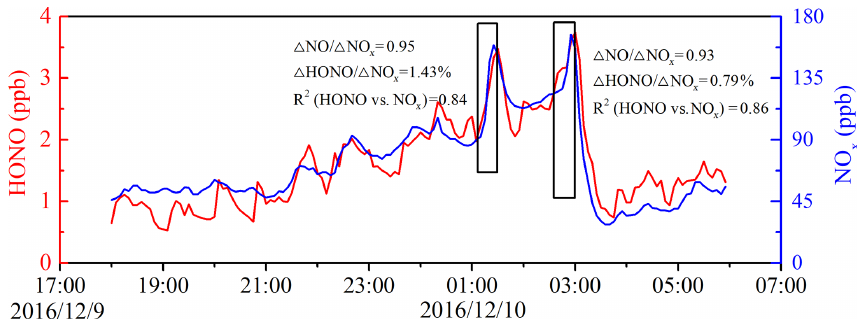
Figure 6. Temporal variation of nocturnal HONO and NO x on 9 to 10 December 2016. The HONO emission ratios were estimated using data collected in the black frames.